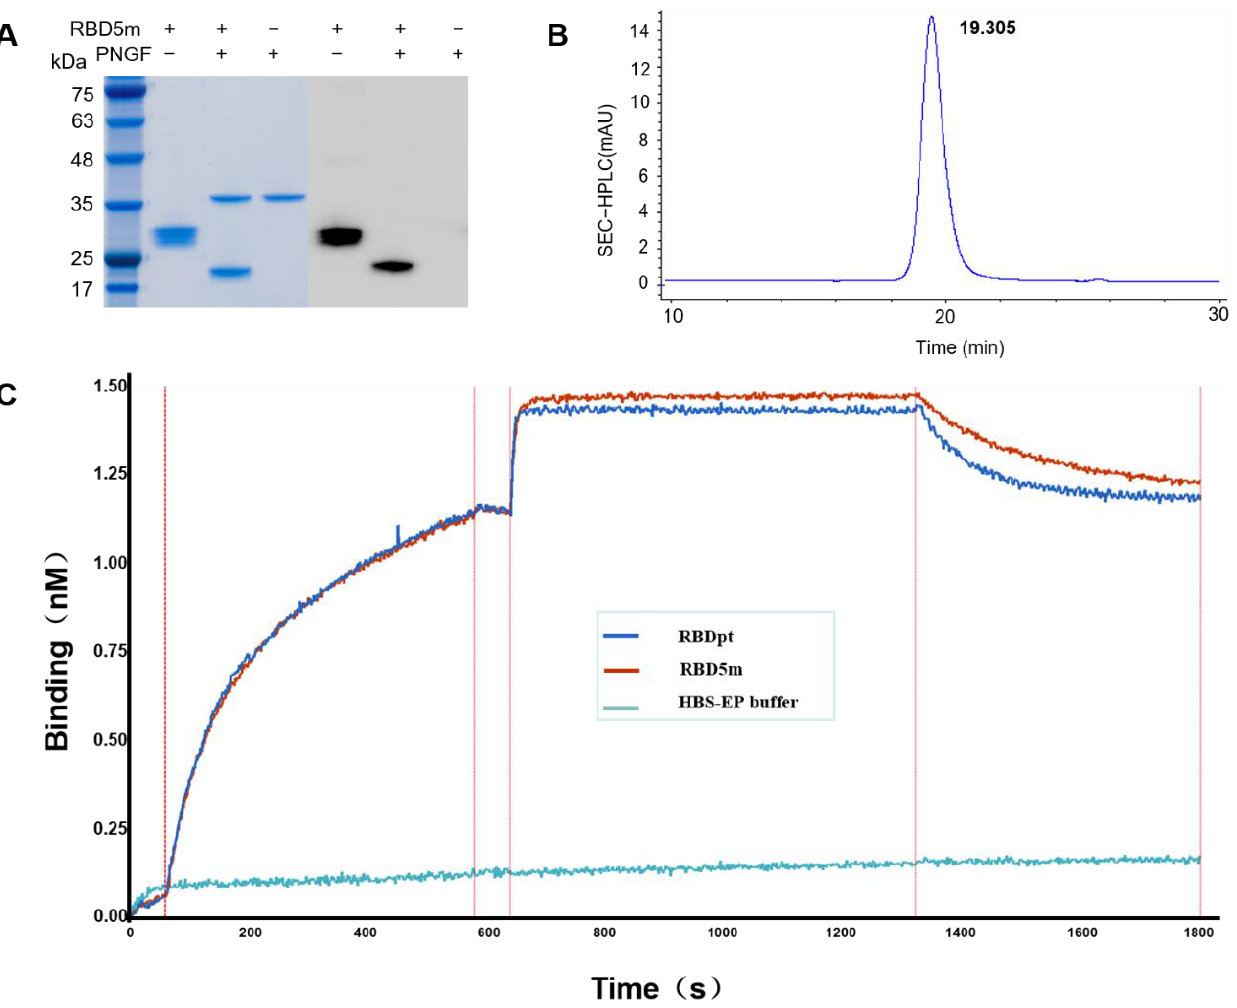
Figure 2. Characterization of RBD5m. ( A ) SDS-PAGE and Western blot analyses of the undigested or PNGF-digested RBD5m protein. ( B ) Purity analysis of the purified RBD5m, conducted with SEC–HPLC. ( C ) Analysis of the RBDpt and RBD5m affinity to ACE2.